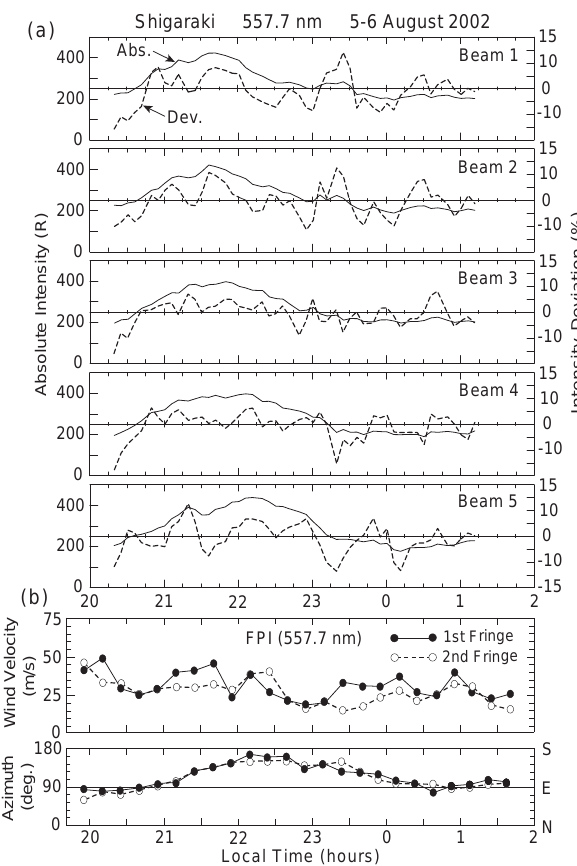
Fig. 4. (a) Temporal variations of absolute intensity ( I 558 ) and de- viation of 557.7-nm airglow intensity ( 1I 558 ) at around 96km al- titude (white circles in Fig. 1) on 5 MU radar beams. (b) Neutral wind speed and azimuth (clockwise from geographic north) of the wind vector determined from first and second fringes of the Fabry- Perot interferometer at Shigaraki.